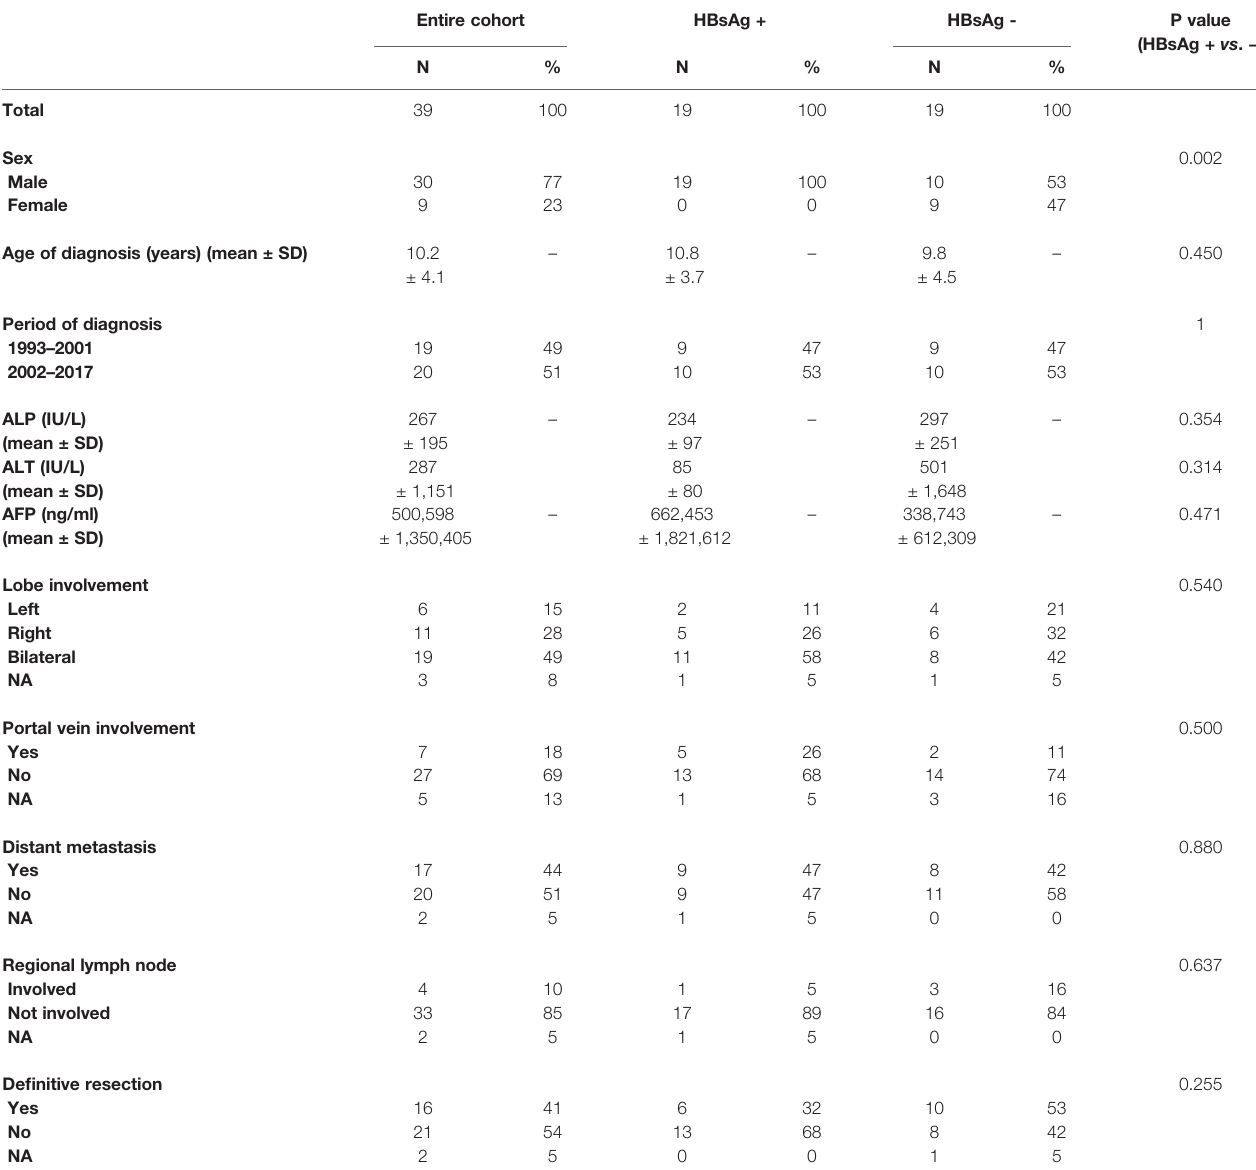
TABLE 1 | Demographics, biochemical, radiographical characteristics of the entire cohort and comparison according to hepatitis B surface antigen (HBsAg) serostatus. Entire cohort HBsAg + HBsAg